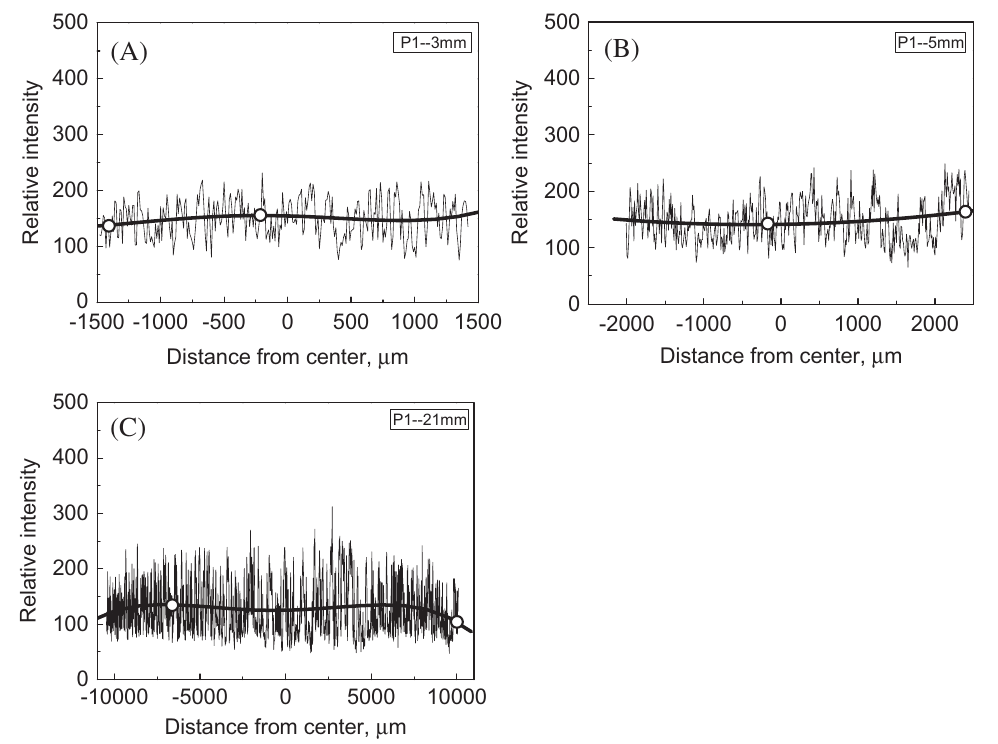
Figure 6: Distribution of P along the thickness direction in sample 1 at the thickness of 3mm, 5mm and 21mm.